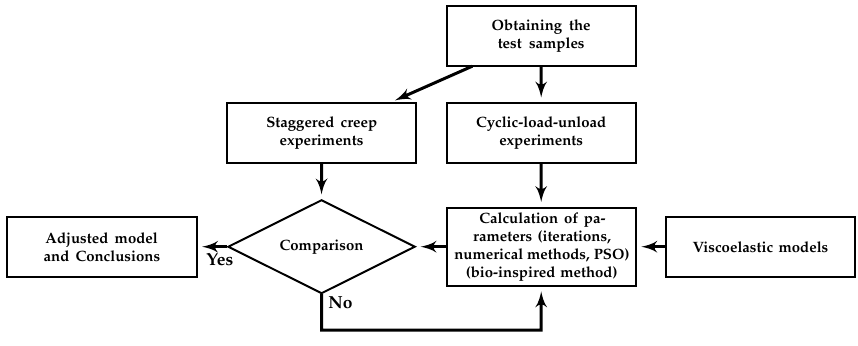
Figure 2. General scheme of the